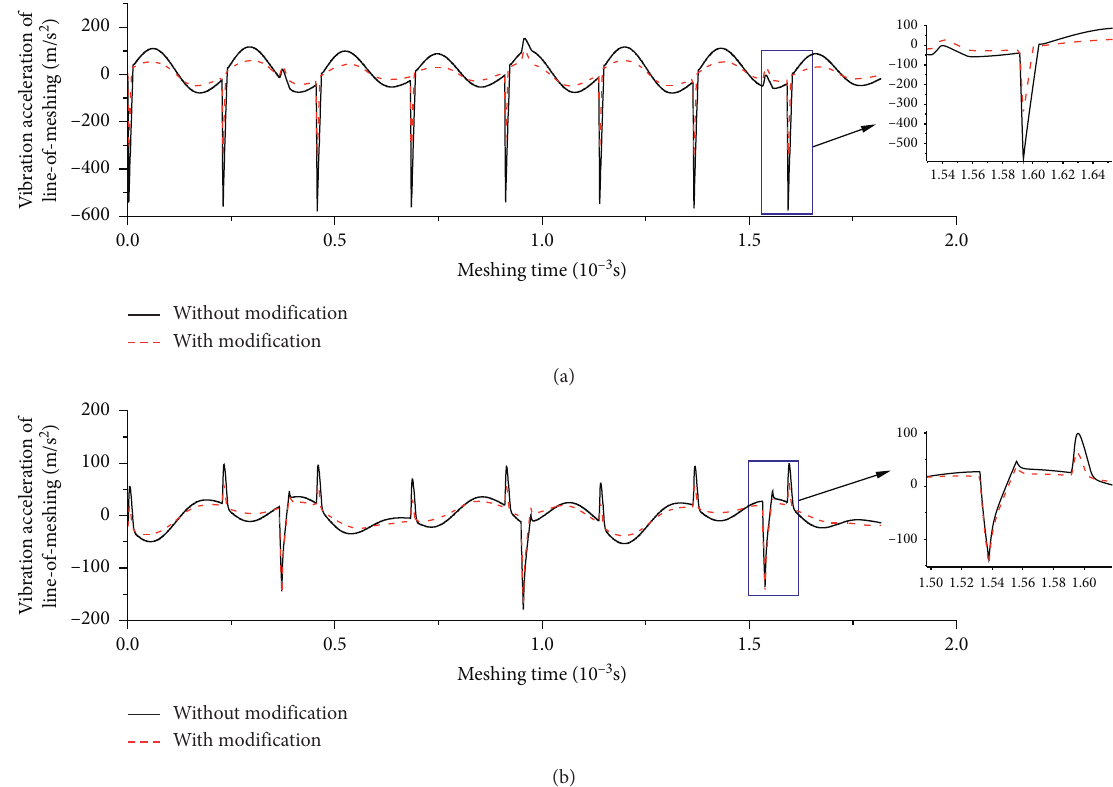
Figure 28: System vibration time domain at 12,000rpm with the modification of the input-stage pinion: (a) time-domain diagram of input- stage gear pair and (b) time-domain diagram of output-stage gear